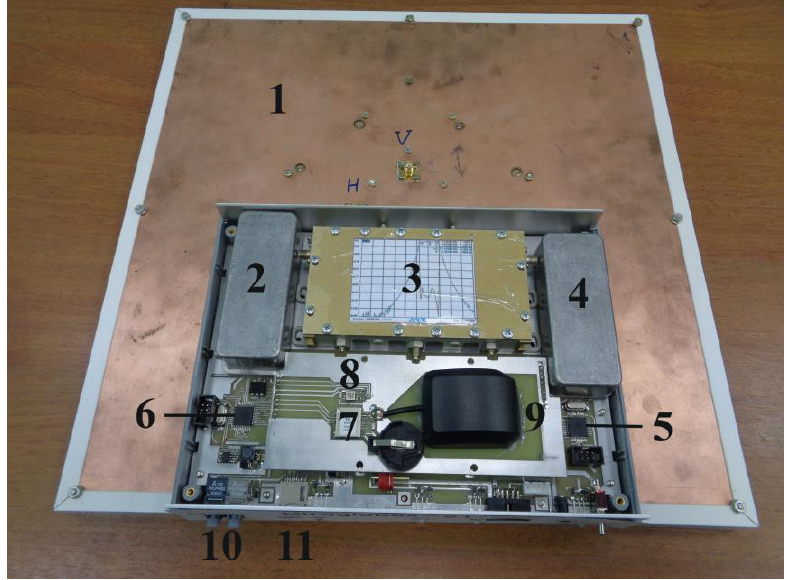
Fig. 1. The design of the new L-band